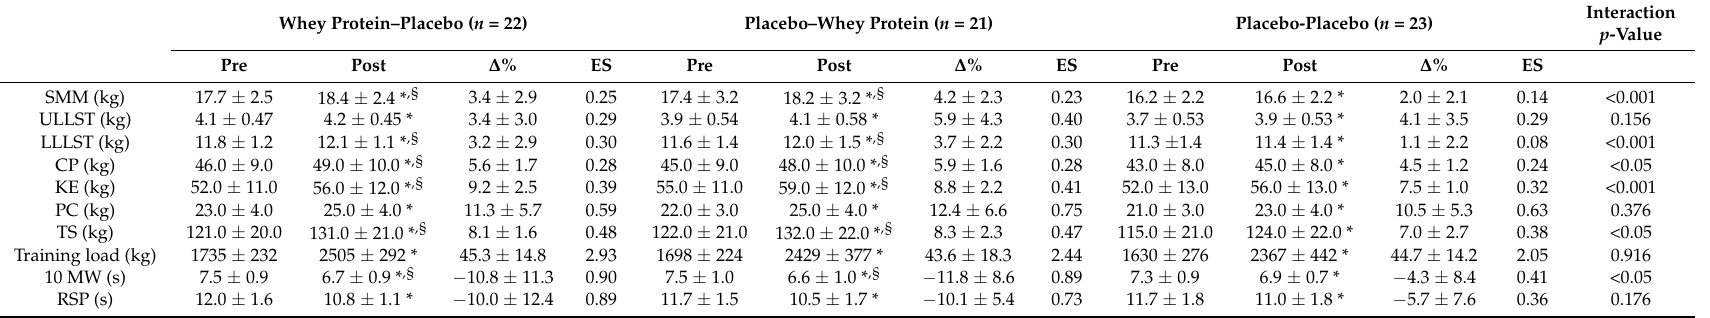
Table 3. Body composition and muscular strength of the older women after the 12-week intervention period ( n = 66). Whey Protein–Placebo ( n = 22) Placebo–Whey Protein ( n =